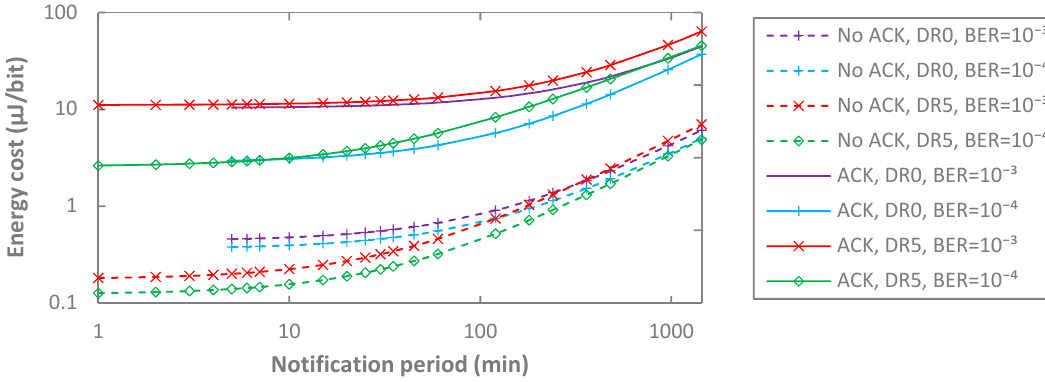
Figure 20. Impact of BER on the energy cost of data delivery, as a function of T Notif , for both unacknowledged and acknowledged transmission, for p coll = 0, and for DR0 and DR5.